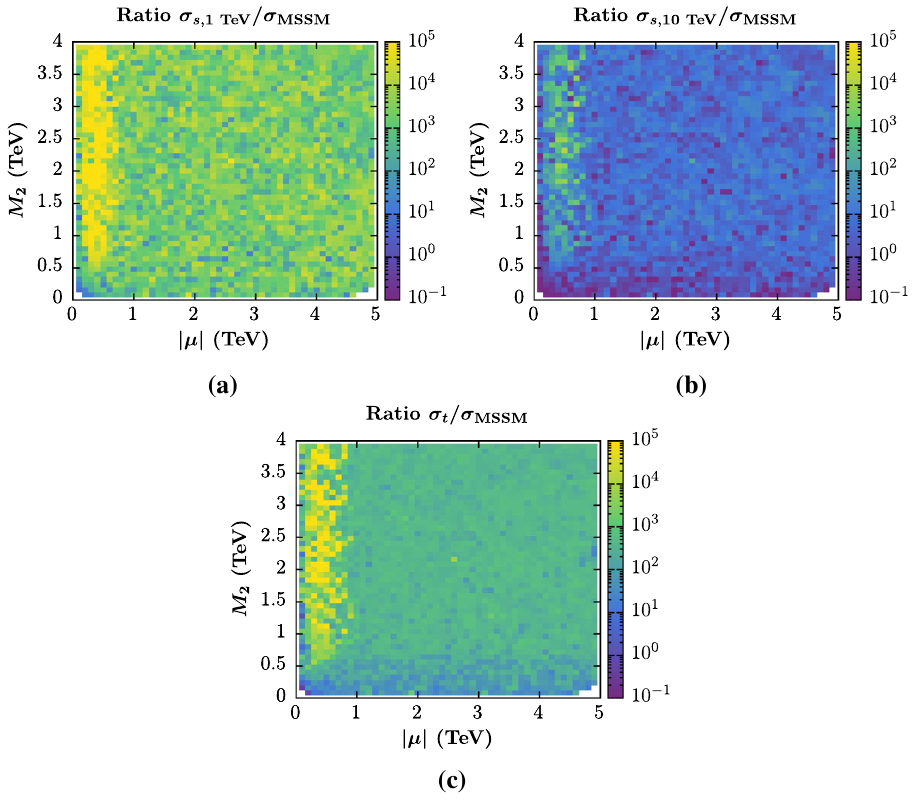
Fig. 8 Ratios of total cross sections for DM pair production in the simplified models to the ones in the MSSM, in the plane of the pMSSM10 parameters | μ | and M 2 , with all other parameters varied implicitly. Shown are the s -channel models with M V = 1 TeV ( a )